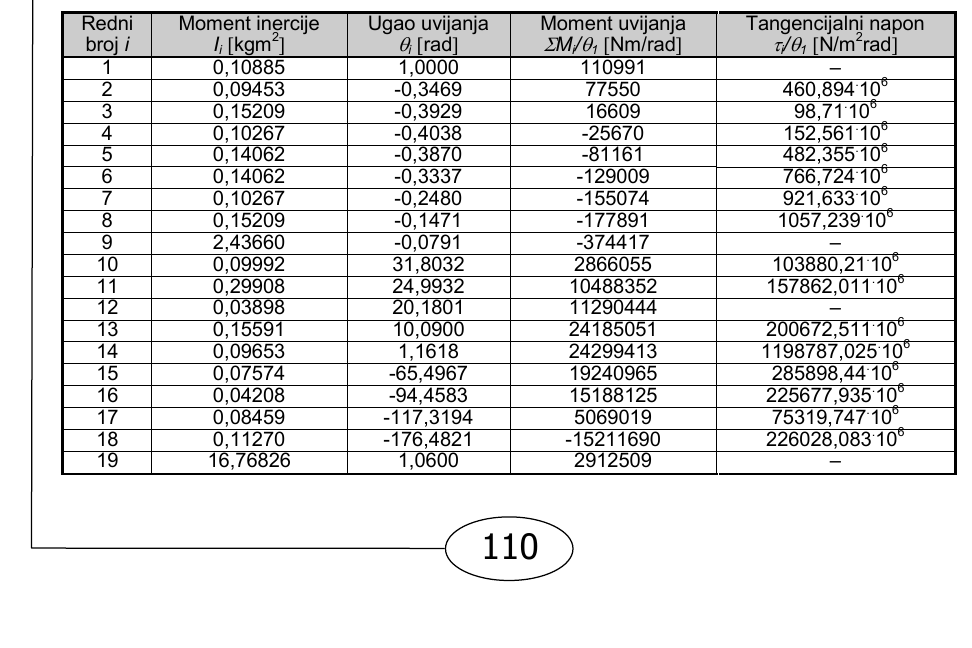
Tabela 5 – Momenti inercije, uglovi uvijanja, momenti uvijanjai tangencijalni naponi za IV oblik oscilovanja